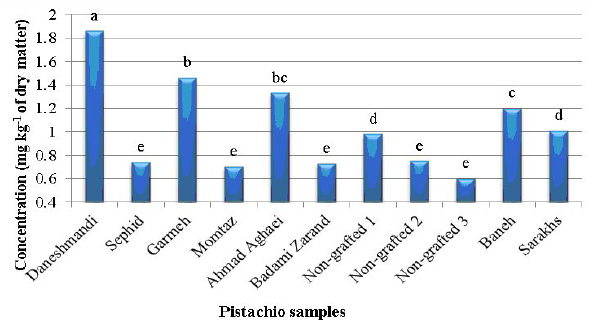
Fig. 9. The strontium concentration of eleven Iranian pistachio samples. (Each column with different letters is significantly dif- ferent (P < 0.05)